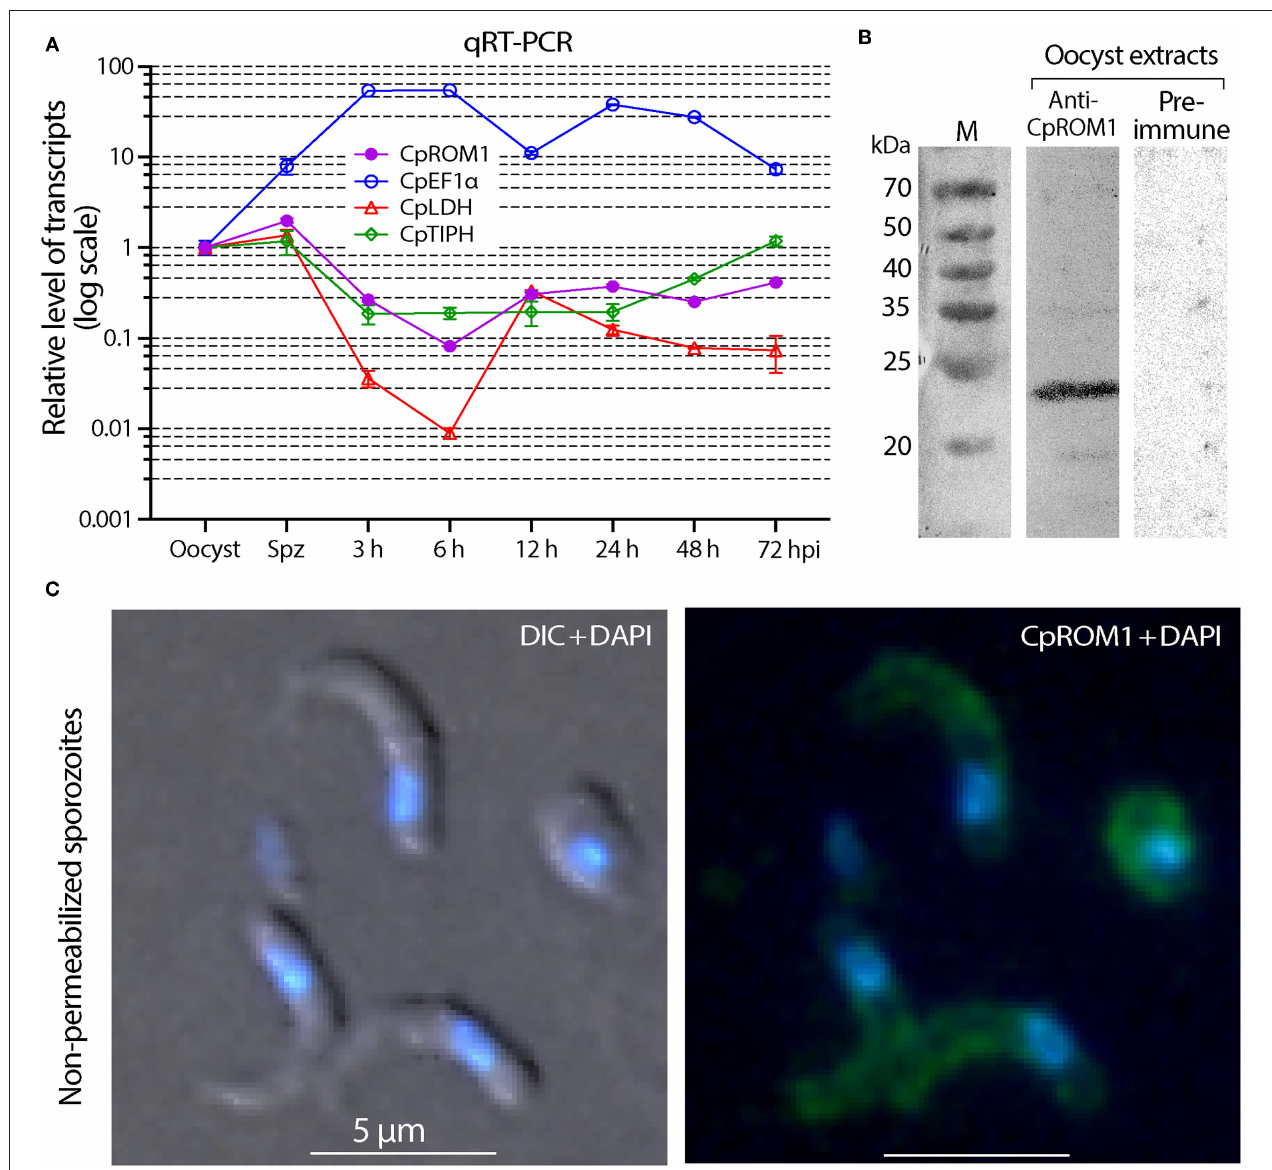
FIGURE 5 | Detection of CpROM1 gene transcript in various life cycle stages and identification of CpROM1 protein in oocyst extracts using Western blot and on sporozoite surfaces using Immunofluorescence assay (IFA). (A) Relative levels of CpROM1 transcript in oocysts, excysted sporozoites, and intracellular parasite stages at different hours post-infection (hpi). Three previously identified genes were detected in parallel and used as references and for quality control. (B) Western blot analysis of CpROM1 using an optimized protocol (described in Materials and Methods). Note that the band recognized by the anti-CpROM1 antibody has a smaller molecular weight ( ∼ 23 kDa) than predicted (31.3 kDa) due to the high number of hydrophobic amino acids which have high affinity for the SDS molecules. (C) IFA of CpROM1 in free sporozoites fixed with paraformaldehyde but not permeabilized used to show the presence of the protein on the surface of sporozoites. This assay confirmed the presence of some CpROM1 protein on the sporozoite surface (green), although the fluorescence signals were weak compared with signals of fixed and permeabilized samples. The signal levels were adjusted in Photoshop for better visualization. The nuclei were counterstained with 4,6-diamidino-2-phenylindole (DAPI) (blue); DIC, differential interference